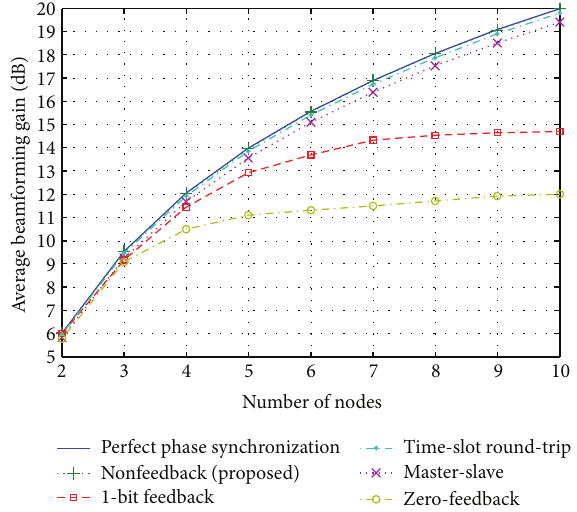
Figure 9: Beamforming gain of proposed nonfeedback technique versus other